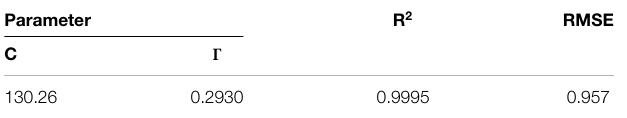
TABLE 4 | Data for parameters of RS-SVR model used for the random displacement prediction. Parameter